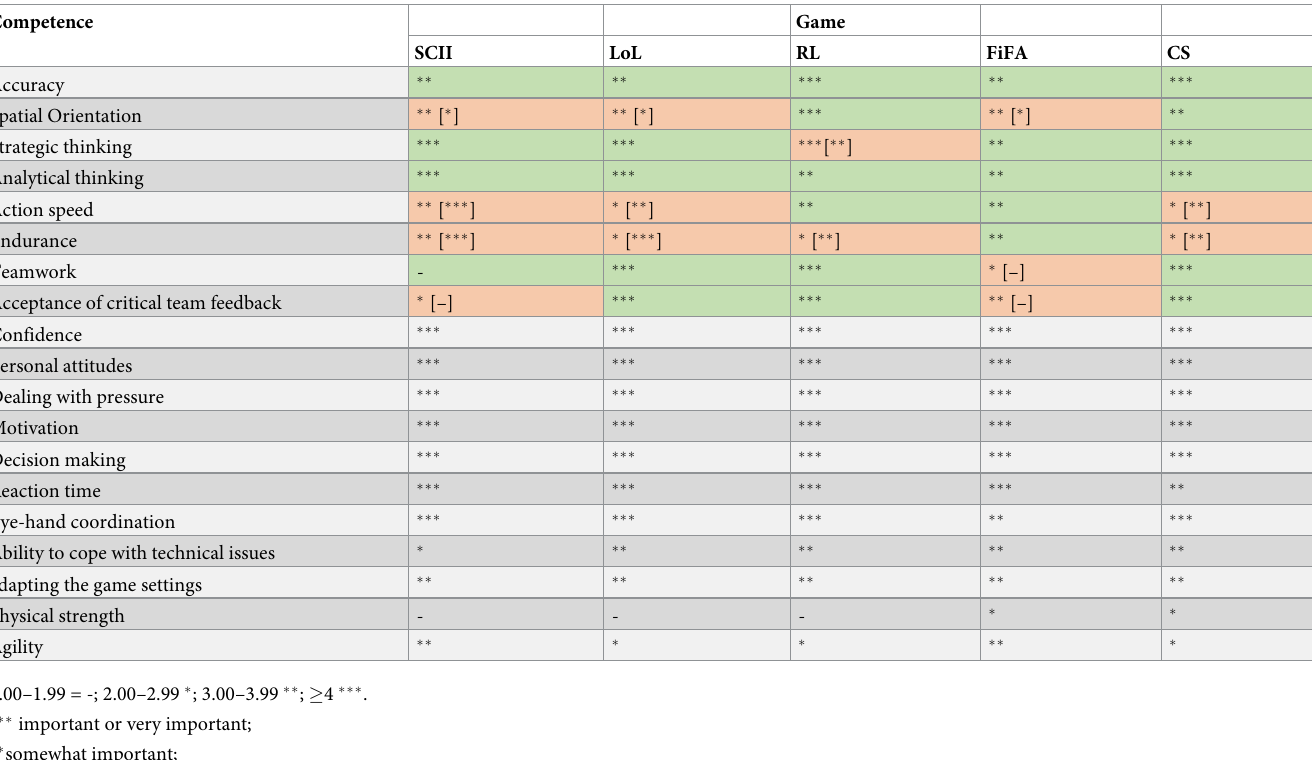
Table 27. Results regarding the differences between the esports in competence importance estimation (Green = Confirmed assumption; Red = non-confirmed assumption).